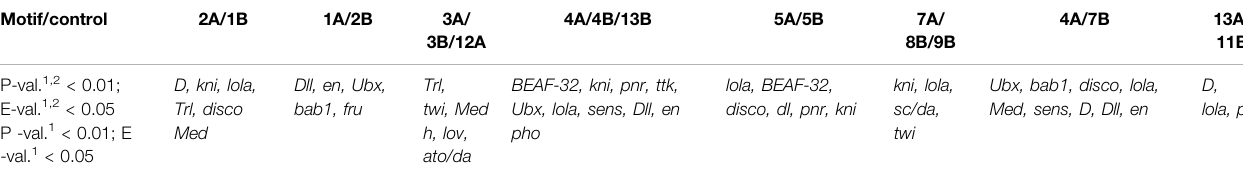
TABLE 3 | Enrichment of evolutionarily conserved sequences with transcription factor binding sites (MEME Suite 5.4.1, AME